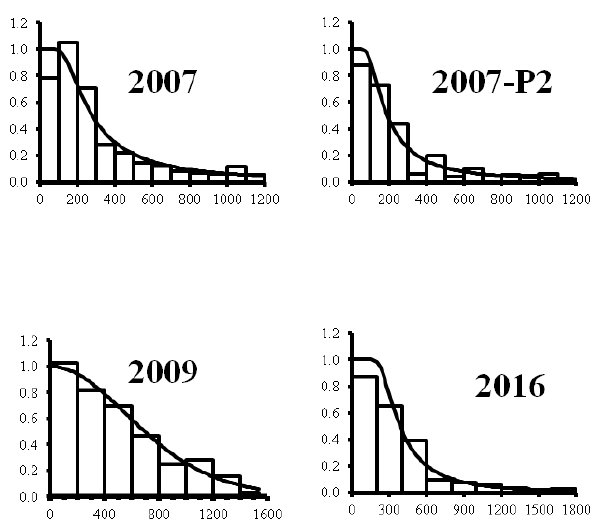
Figure 9. Detection functions (solid line) and cue sightings of common minke whales by survey. X-axis – radial distance (m); Y-axis – sighting probability, corrected for surface area.